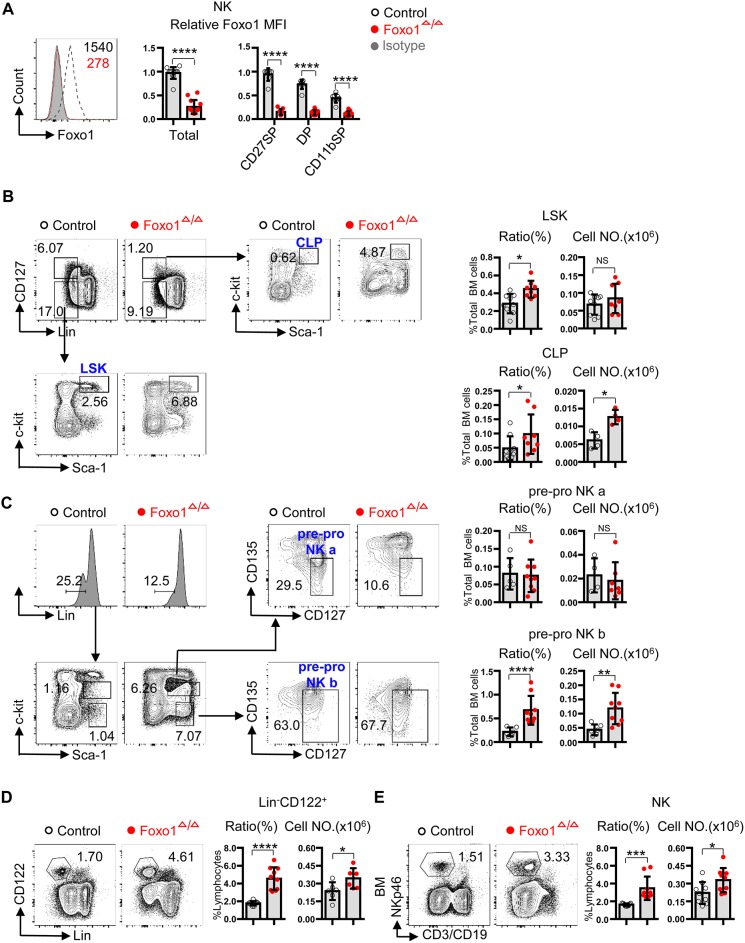
Hematopoietic-specific deletion of Foxo1 resulted in increased proportion and quantity of CLP, pre-pro NK, and NK cells. (A) Intracellular flow cytometric analysis of Foxo1 expression (mean fluorescence intensity (MFI) relative to littermate control) in splenic NK cells (CD3−CD19−NKp46+) from control vs. Foxo1Δ/Δ mice. (B) Frequency and enumeration of LSK (Lin−CD127−Sca-1+c-Kit+) and CLP (Lin−CD127+Sca-1+c-Kit+) in the bone marrow (BM) from control vs. Foxo1Δ/Δ mice. Lin: CD3, CD19, B220, CD4, CD8, CD11b, NKp46, Gr1, and Ter119. (C) Frequency and enumeration of pre-pro NK a (Lin−Sca-1+c-KitintCD135−CD127+) and pre-pro NK b (Lin−Sca-1+c-Kit−CD135−CD127+) in the BM from control vs. Foxo1Δ/Δ mice. Lin: CD3, CD19, B220, Gr1, Ter119, CD4, CD8, CD11b, and NKp46. (D) Frequency and enumeration of Lin−CD122+ cell in the BM from control vs. Foxo1Δ/Δ mice. Lin: CD3, CD19, Gr1, and Ter119. (E) Frequency and enumeration of NK cells (CD3−CD19−NKp46+) in the BM from control vs. Foxo1Δ/Δ mice. Ratio of LSK, CLP, pre-pro NK a and pre-pro NK b cells are relative to total BM cells (A–C), whereas ratio of Lin−CD122+ and CD3−CD19−NKp46+NK cells are relative to total lymphocytes. Each dot represents one mouse. At least 3 littermates were included for (A–E) (Error bars indicate SD; *p < 0.05, **p < 0.01, ***p < 0.001, and ****p < 0.0001, control vs. Foxo1Δ/Δ mice; unpaired Student's t-test with generalized linear models).